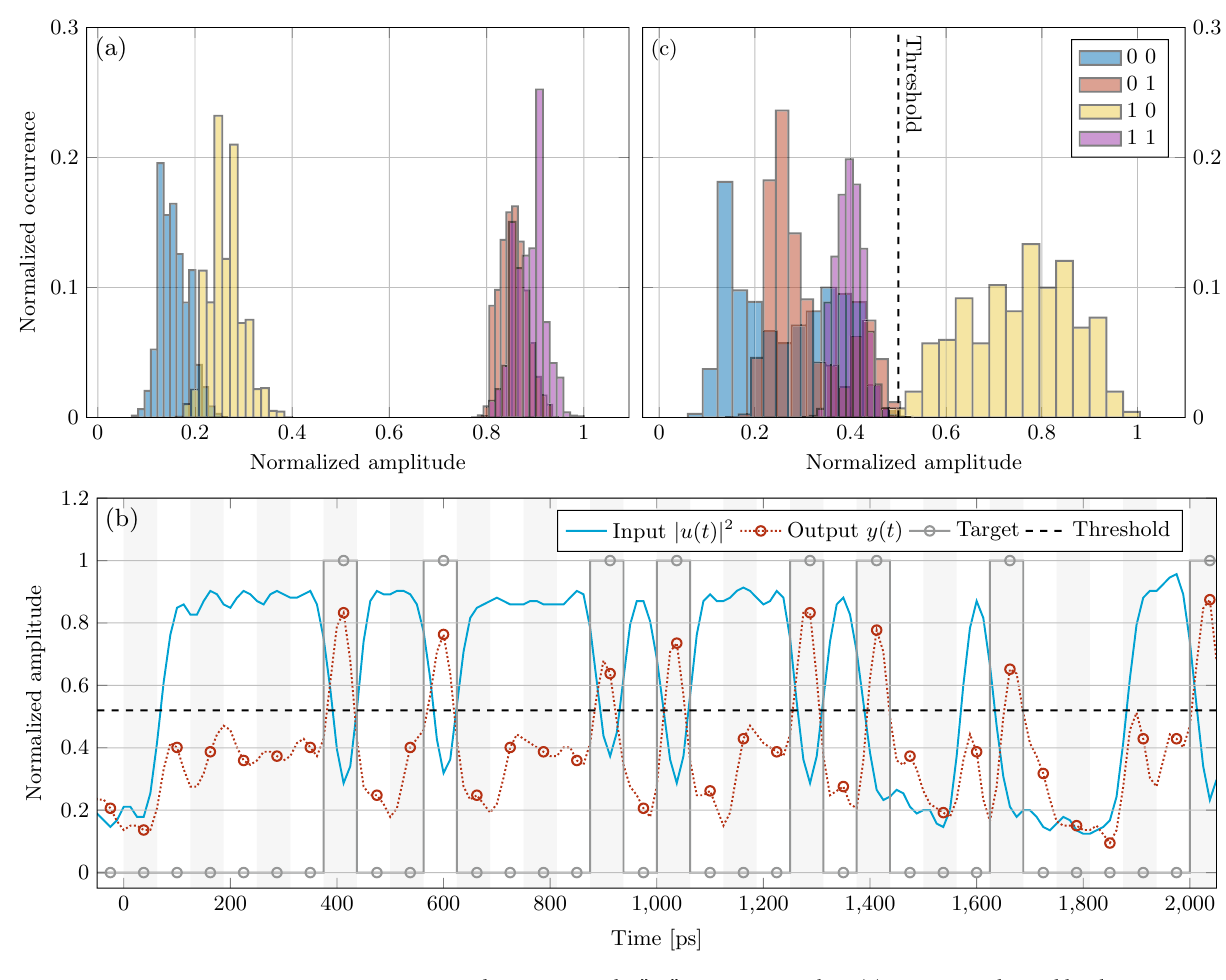
Figure 4. Perceptron trained to recognize the ”10” pattern at 16 Gbps. ( a ) Input optical signal levels distribution of the 2nd bit of the 2-bit patterns given in the inset. ( b ) Time traces for the input signal u ( t ) (blue line) and for the perceptron output y ( t ) (red dashed line). Dashed black line is the optimal threshold. Gray circles refer to the target response, red circles indicate the best samples at the perceptron output. Vertical stripes indicate the bit slots. ( c ) Output signal levels distribution of the 2nd bit of the 2-bit patterns given in the inset. The vertical dashed line marks the optimal